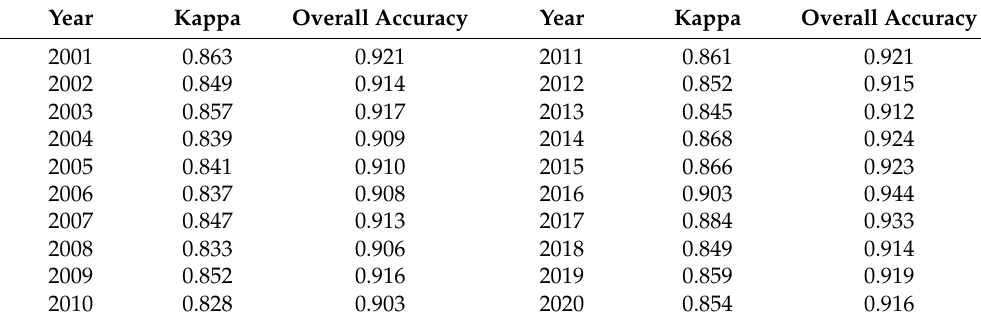
Table 1. Overall accuracy and kappa coefficient values of land use